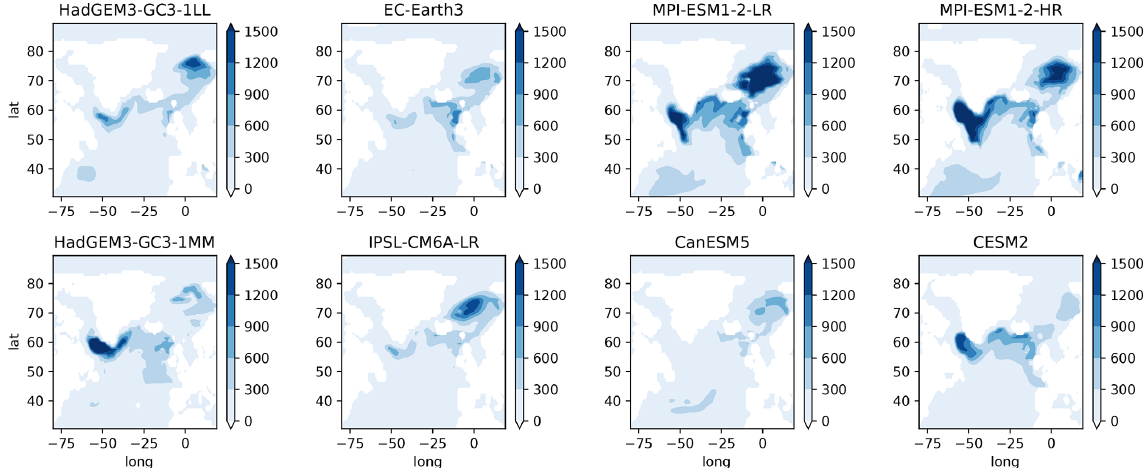
Figure 10. Time mean March mixed-layer depth (m) in the control experiments. Models in the upper panels are those where the AMOC always recovers during subsequent recovery experiments, and models in the bottom panels are those where the AMOC stays in a weak state in at least one experiment.